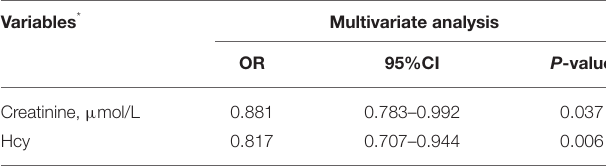
TABLE 4 | Multivariate analysis on the risk of poor postoperative